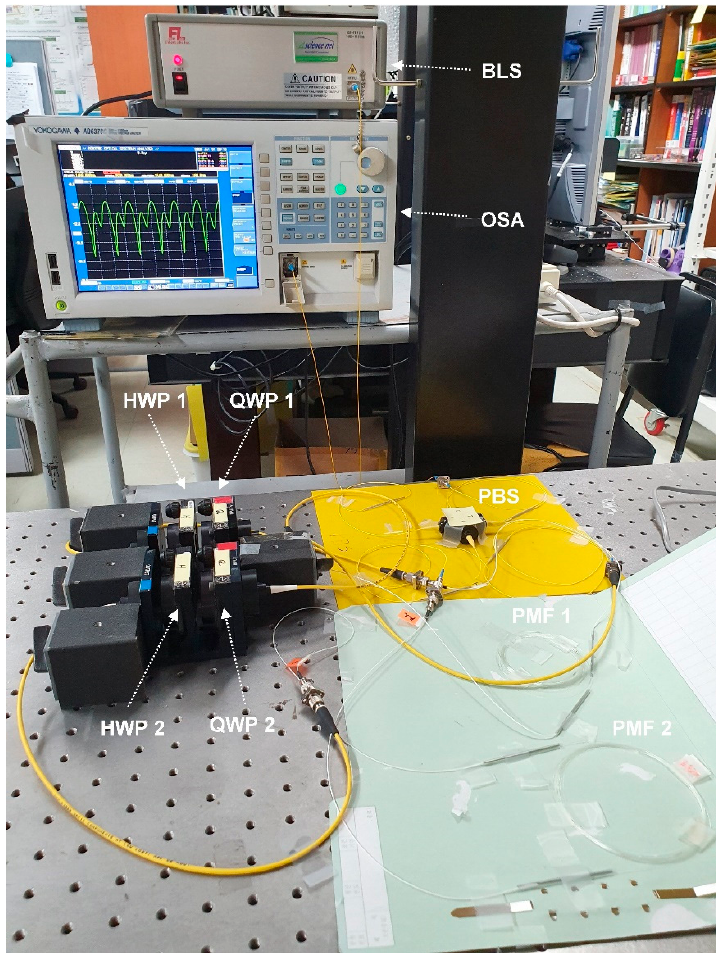
Figure 6. Actual experimental setup for measurement of phase-modulated transmission spectra of GTF ( t GTF 2 ).